Question: What direction does the quantity move in — increasing or decreasing?
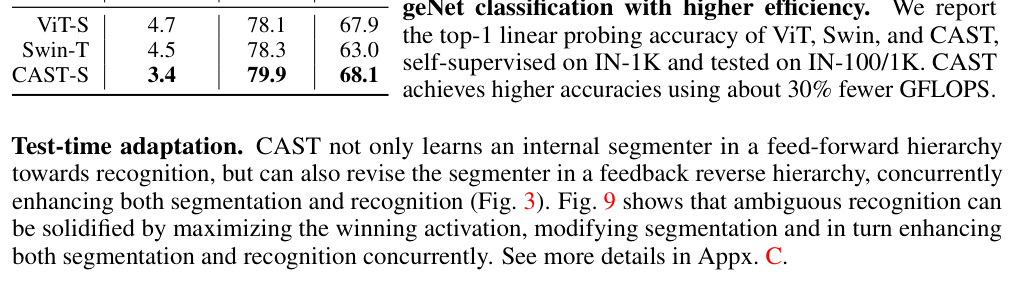
Answer: increasing